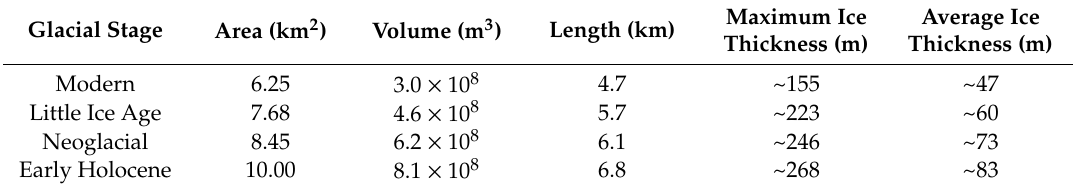
Table 1. Reconstructed glacial extent parameters for the Qiangyong Glacier at di ff erent Holocene stages. Glacial